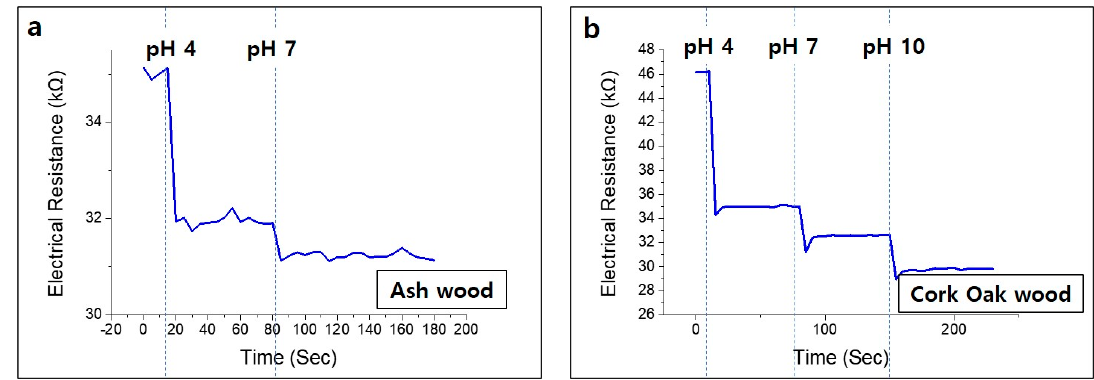
Figure 10. Change of sensor electrical conductivity according to pH value with a multiple buffer drop test; ( a ) ash wood (two times), ( b ) cork oak wood (three times).